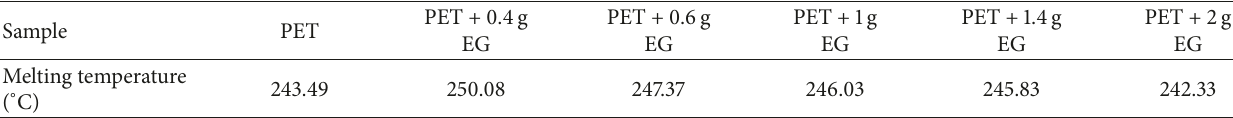
Figure 3: DSC curves for untreated and EG treated PET. (a) DSC for temperature range between 175 and 275 ∘ C, and (b) DSC for the entire temperature range used in the experiment. Table 2: Melting point values for all the nontreated PET and EG treated PET